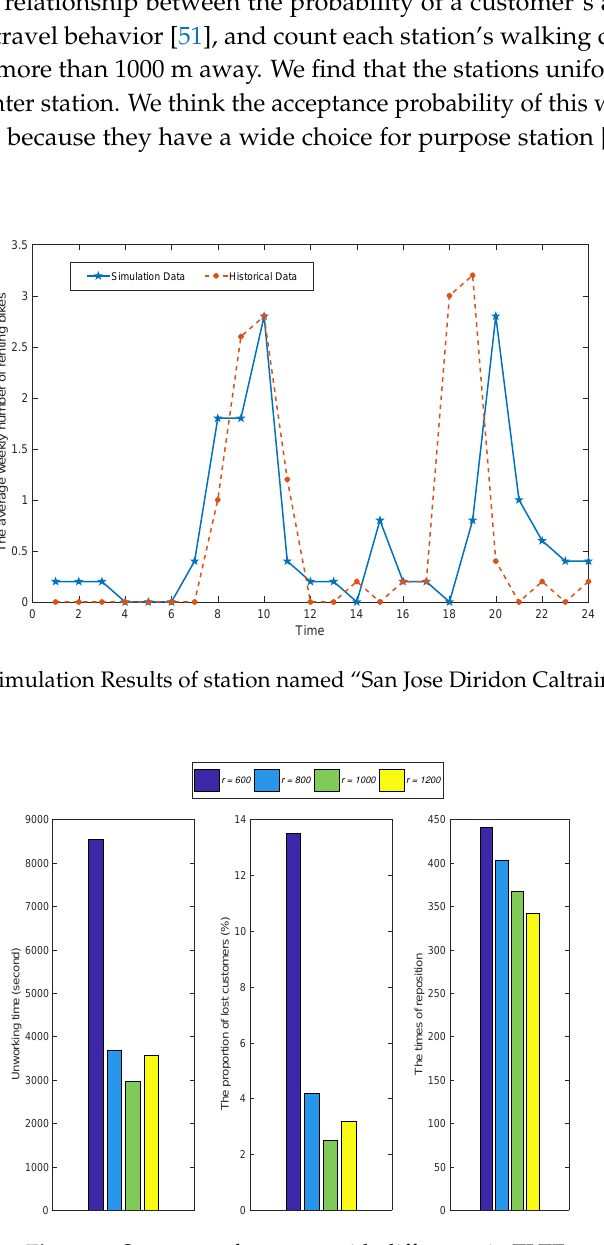
Figure 7. System performance with different r in